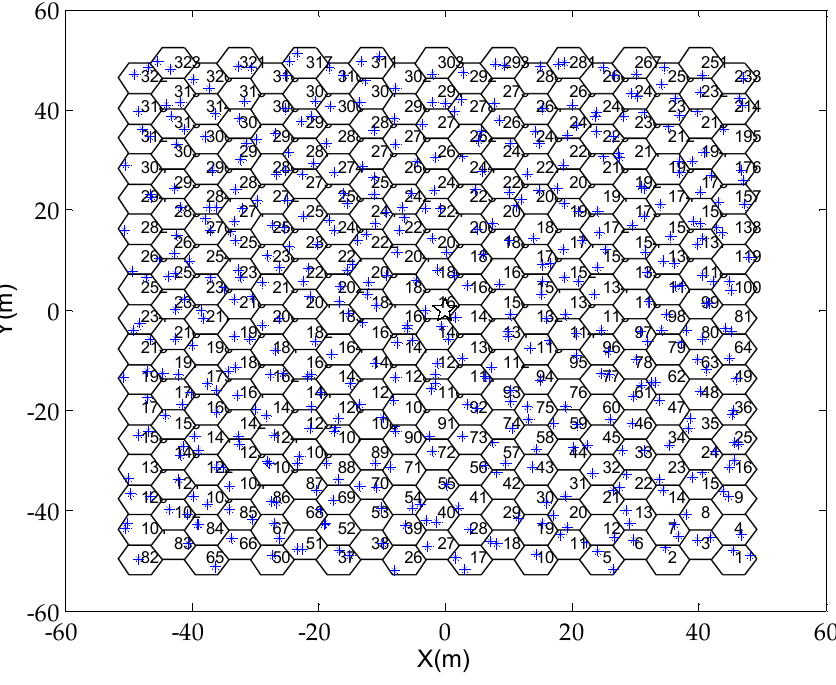
Figure 6. The scenario diagram.